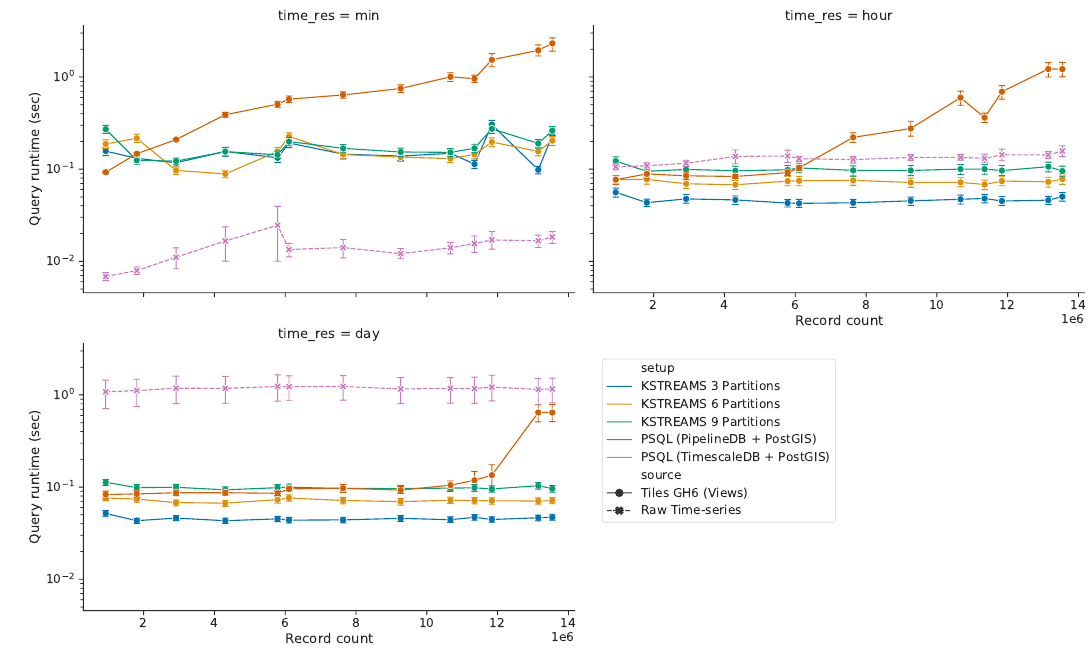
Figure 15. Query response time vs. volume of ingested data: HS queries with time